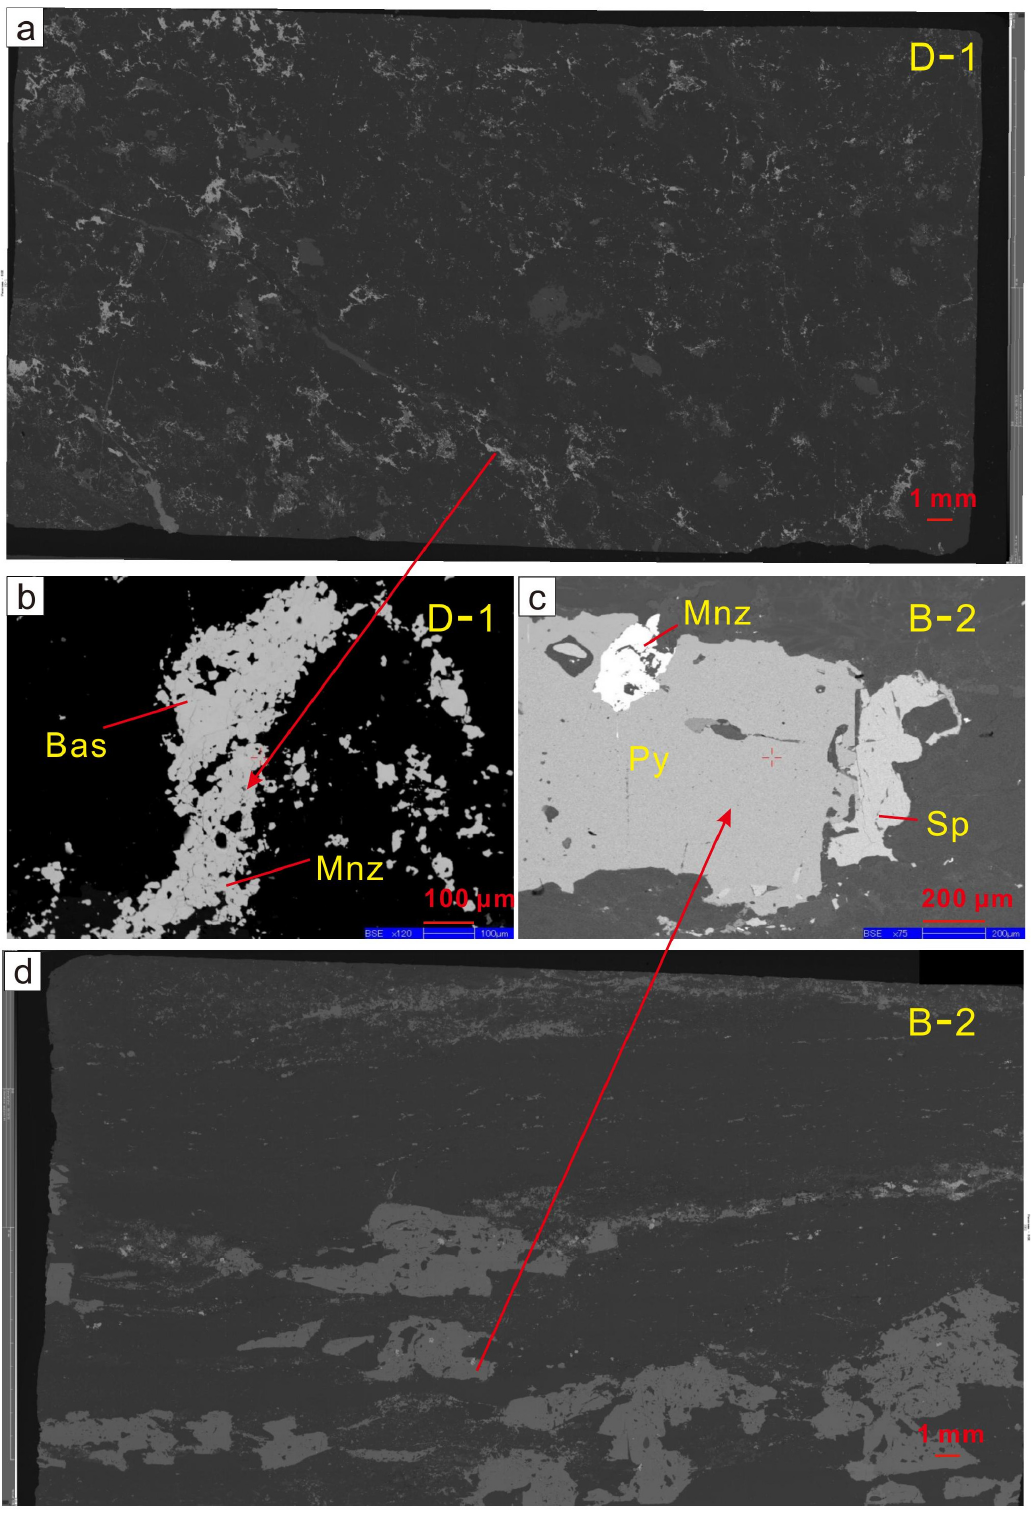
Figure 3. Backscattered electron images showing characteristic mineral assemblages and textures observed in the Bayan Obo deposit. ( a , d ) are whole BSE scans, ( b , c ) are detail BSE images. Mnz—monazite; Bas—bastnasite; Sp—Sphalerite; Py—Pyrite. The mineral composition of Fe-1 includes biotite (31.56%), aegirine (21.63%), siderite (9.93%), magnesio-riebeckite (9.35%), hematite/magnetite (6.09%), orthoclase (3.65%),